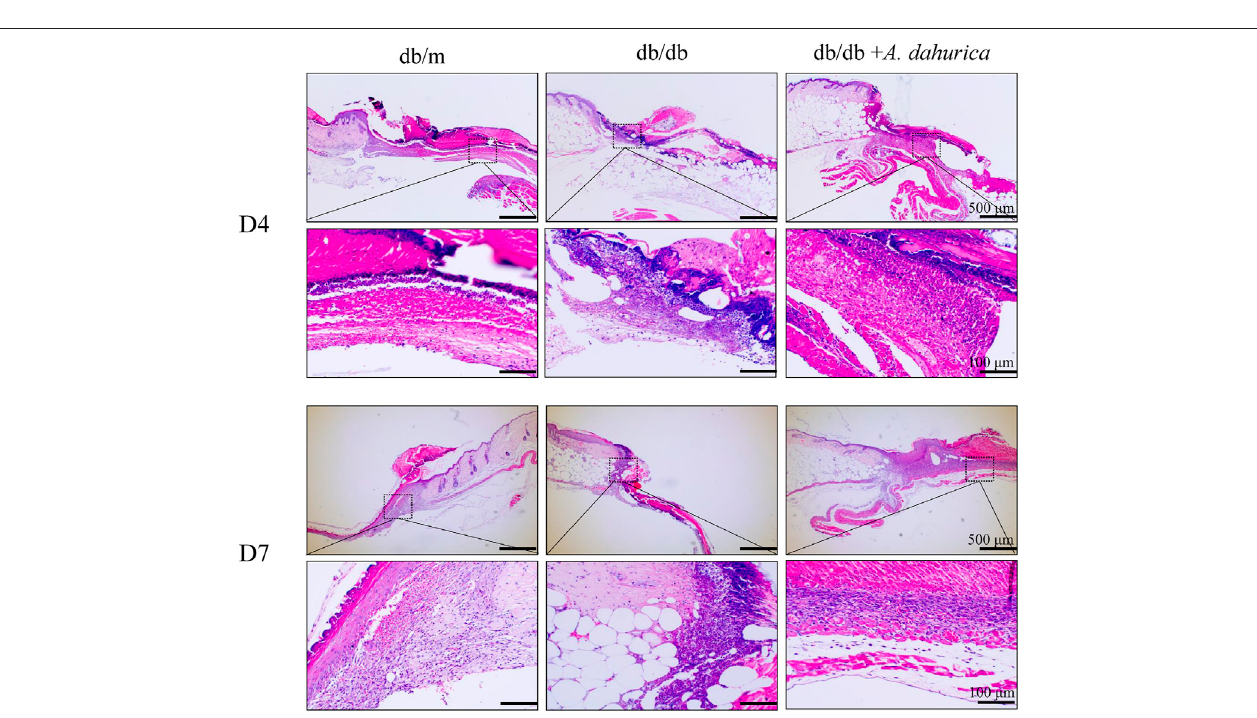
FIGURE3| Representative images ofHand Estainingsections ofwoundsat days 4and days7post-operation (scale bar:500,100 μ m), n (cid:2) 6animalsper group.